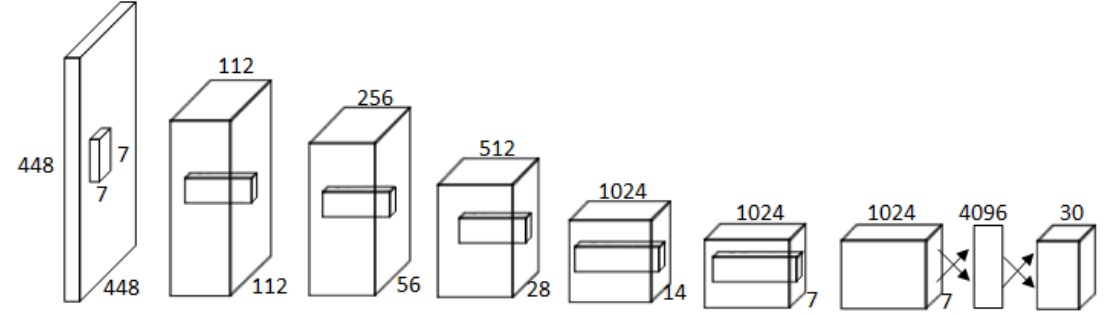
Figure 2. Architecture of the YOLO-v2 model. This network has 24 convolutional layers followed by 2 fully connected layers. Alternating 1 × 1 convolutional layers reduce the feature space from preceding layers. We pretrain the convolutional layers on the ImageNet classification task at half of the resolution (224 × 224 input image) and then double the resolution for